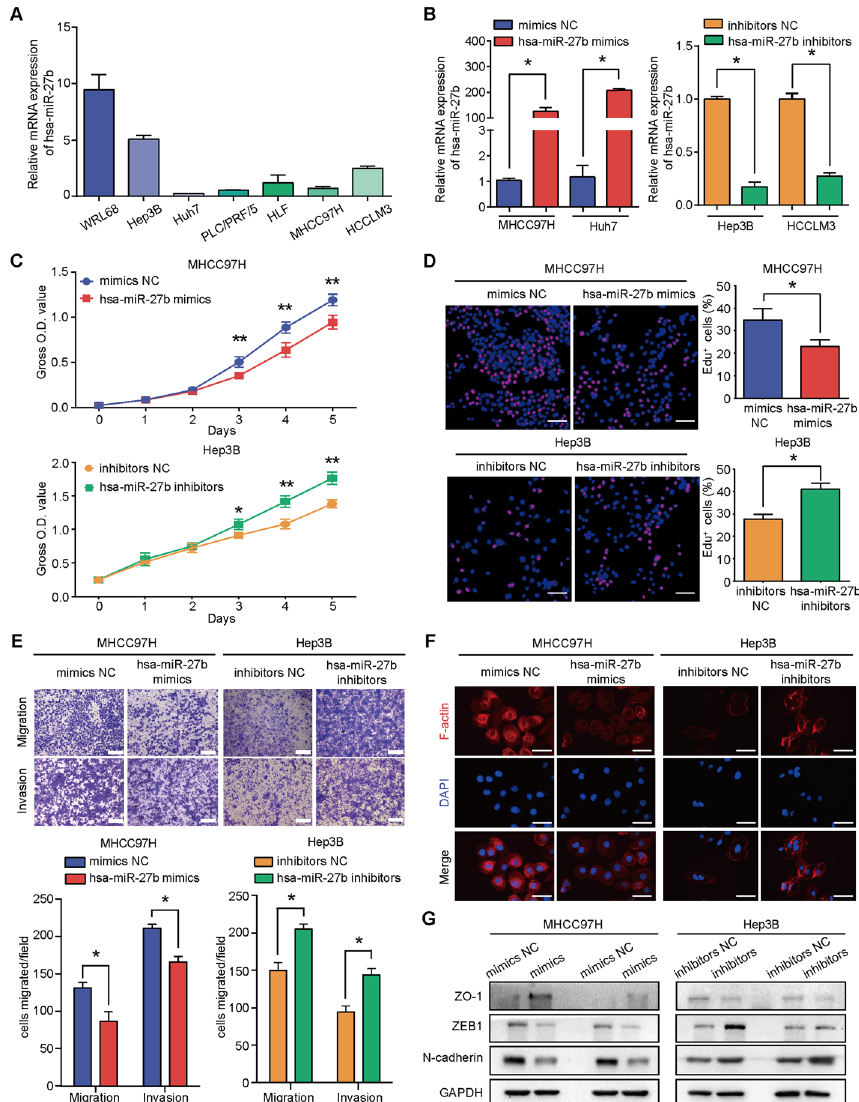
Fig. 2 Hsa-miR-27b inhibits the proliferation and migration of HCC cells in vitro. A Endogenous expression of hsa-miR-27b in WRL68 and HCC cell lines. Data were normalized to U6 and are shown as fold change compared with HLF cells ( n 3). B Overexpression or knockdown of hsa-miR-27b in HCC cells using = hsa-miR-27b mimics or inhibitors, respectively, as measured by qRT-PCR. Data were normalized to U6 and are shown as fold change relative to the control cells ( n 3, Mann–Whitney test). C The proliferation of = the indicated cells with overexpression or knockdown of hsa-miR-27b as measured by CCK-8 assays ( n 5, = Kruskal–Wallis test). D Representative images of the EdU incorporation assay (left). Scale bar: 100 μm; quantification of EdU-positive cells (right) ( n 3, Mann–Whitney test). E Representative images (top) and = quantification (bottom) of cells that migrated or invaded in the indicated groups ( n 3, Mann–Whitney test). = Scale bar, 200 μm. F Representative pictures of phalloidin staining for F-actin (red) in the indicated cells. DAPI was used to show the nucleus (blue). Scale bar, 20 μm. G Western blot analysis for EMT markers as indicated. GAPDH was used as a loading control. All experiments were repeated three times. * p < 0.05. ** p < 0.01. Data are shown as mean SD. NC, negative ±